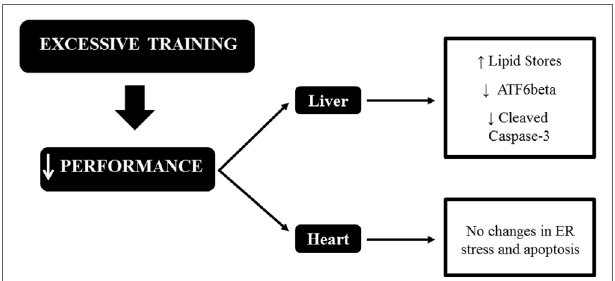
FigUre 6 | Schematic model summarizing the relationships between endoplasmic reticulum (ER) stress, apoptosis, and excessive training in the liver and heart of C57BL/6